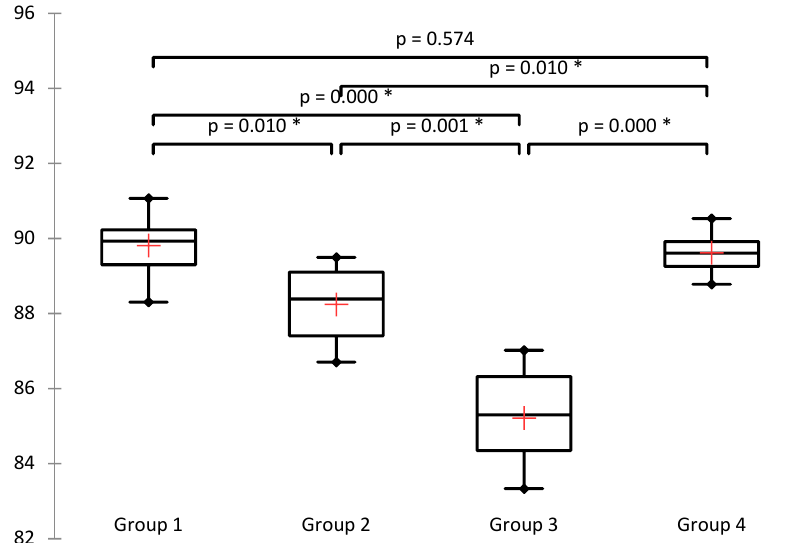
Figure 4. Box plots for SOD activity (inhibition rate %). The Kruskal − Wallis test shows a statistically significant difference in the observed parameter between different groups (at a significance level of 5%); ( χ 2 = 22.023 (7.815), DF = 3, p < 0.0001), * p < 0.05.